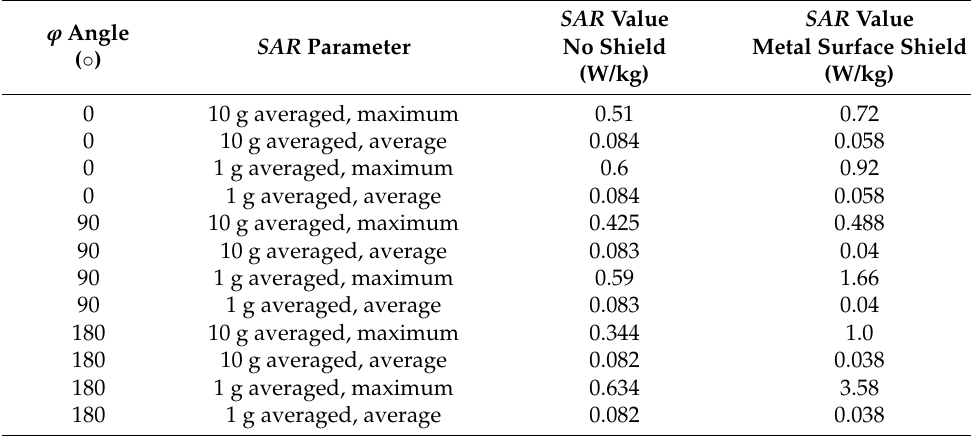
Table 2. SAR parameters for 750 MHz, for θ = 90 ◦ .